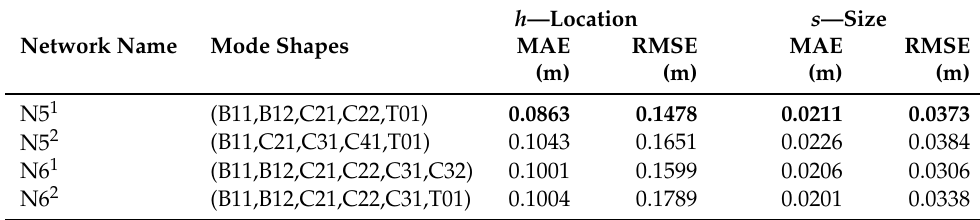
Table 8. The results of the identification of { h , s } on the basis of five or six mode